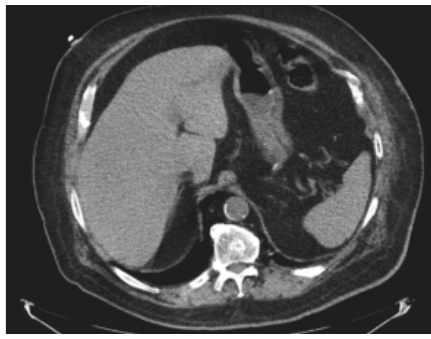
Figure2:CTofabdomenwithcontrastshowingunremarkableliver, spleen, pancreas, and adrenal